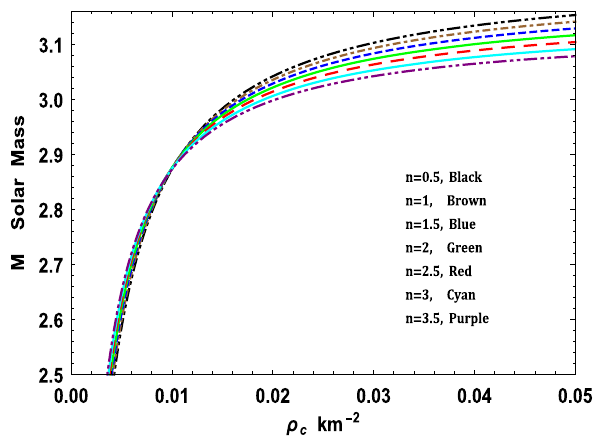
Fig. 18 Variation of total mass with central density for R = 9 . 528 km , a = 0 . 001 km − 2 and β = 0 .